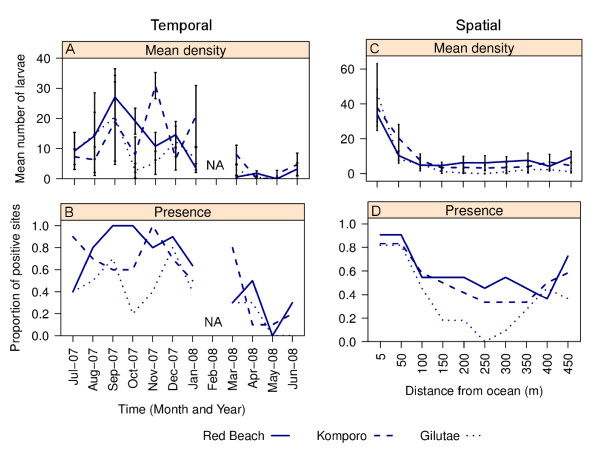
A temporal and spatial comparison of mean larval mosquito density (A, C; mean ± SE) and the proportion of sites containing An. farauti larvae (B, D).